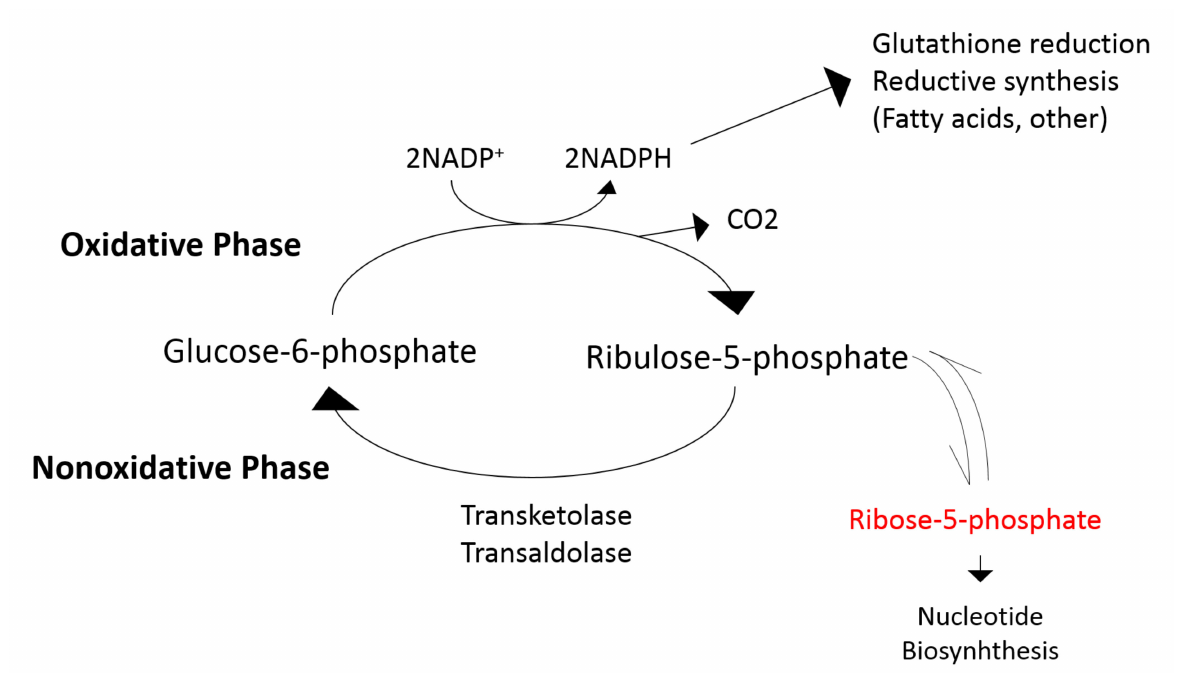
Figure 3. Illustration of the pentose phosphate pathway (PPP). Allopurinol-mediated inhibition of PPP reduces ribose-5-phosphate availability for purine synthesis, which likely contributes to the urate-lowering effect of the drug. Allopurinol, additionally, inhibits the oxidative branch of the PPP and may result in reduced availability